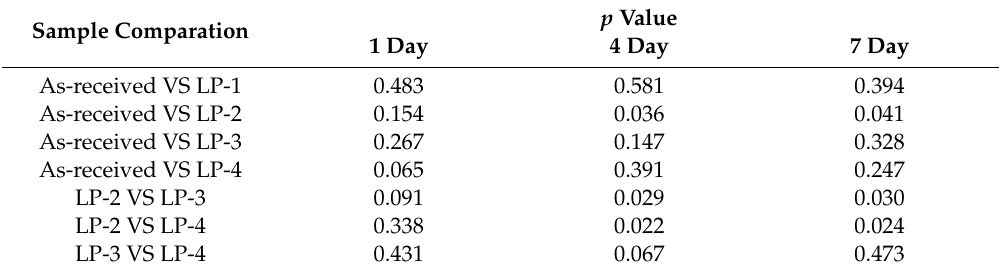
Table 3. ANOVA analysis of cell proliferation evaluated via CCK-8